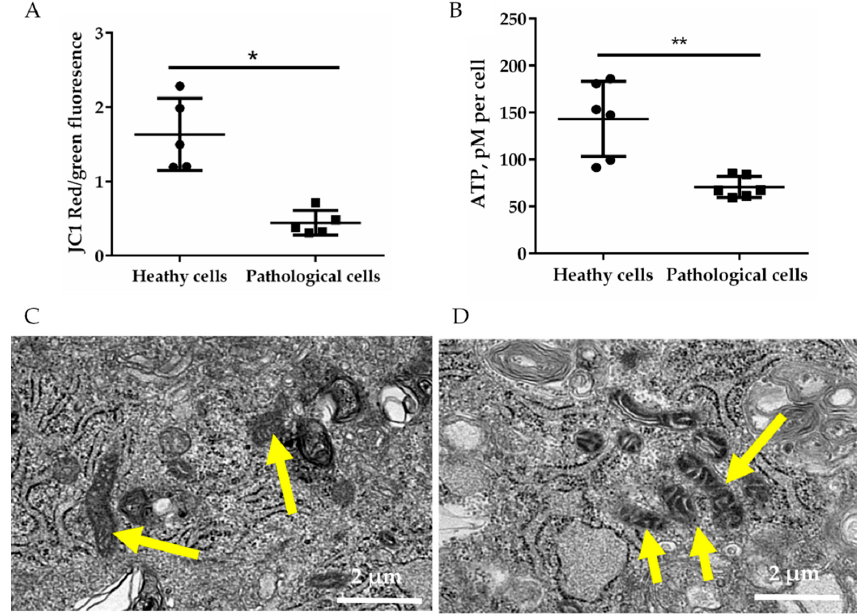
Figure 2. Energetic status of healthy and pathological hmMSC. ( A ) Mitochondrial membrane potential measured by 5,5 (cid:48) ,6,6 (cid:48) -Tetrachloro-1,1 (cid:48) ,3,3 (cid:48) -tetraethyl-imidacarbocyanine iodide (JC1) dye. ( B ) Level of ATP in healthy and pathological hmMSCs (picomoles (pM) of adenosine triphosphate (ATP) per cell). Representative micrographs of electron microscope of healthy ( C ) and pathological ( D ) hmMSC are shown, scale bar = 2 µ m. Yellow arrows indicate mitochondria. Data are shown as mean ± standard deviation (SD). The * p ≤ 0.05, ** p ≤ 0.01, n = 5 from three experiments. Student t test was calculated by Graphpad Prism 6